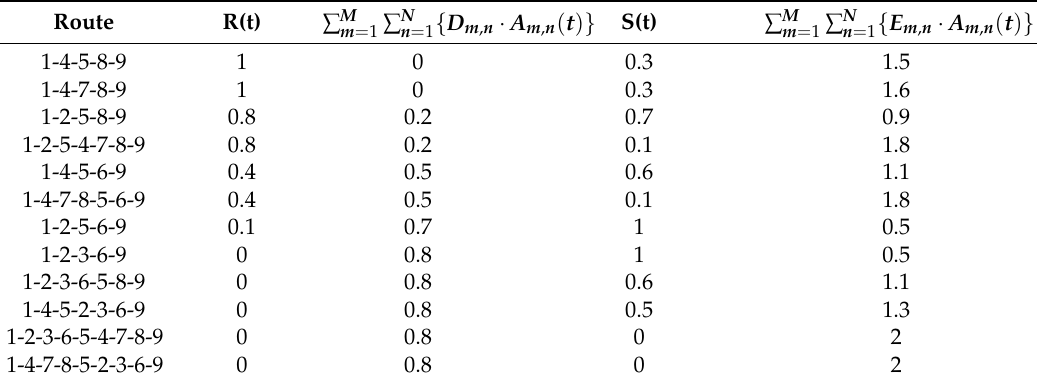
Table 4. Simulation results for a 3 × 3